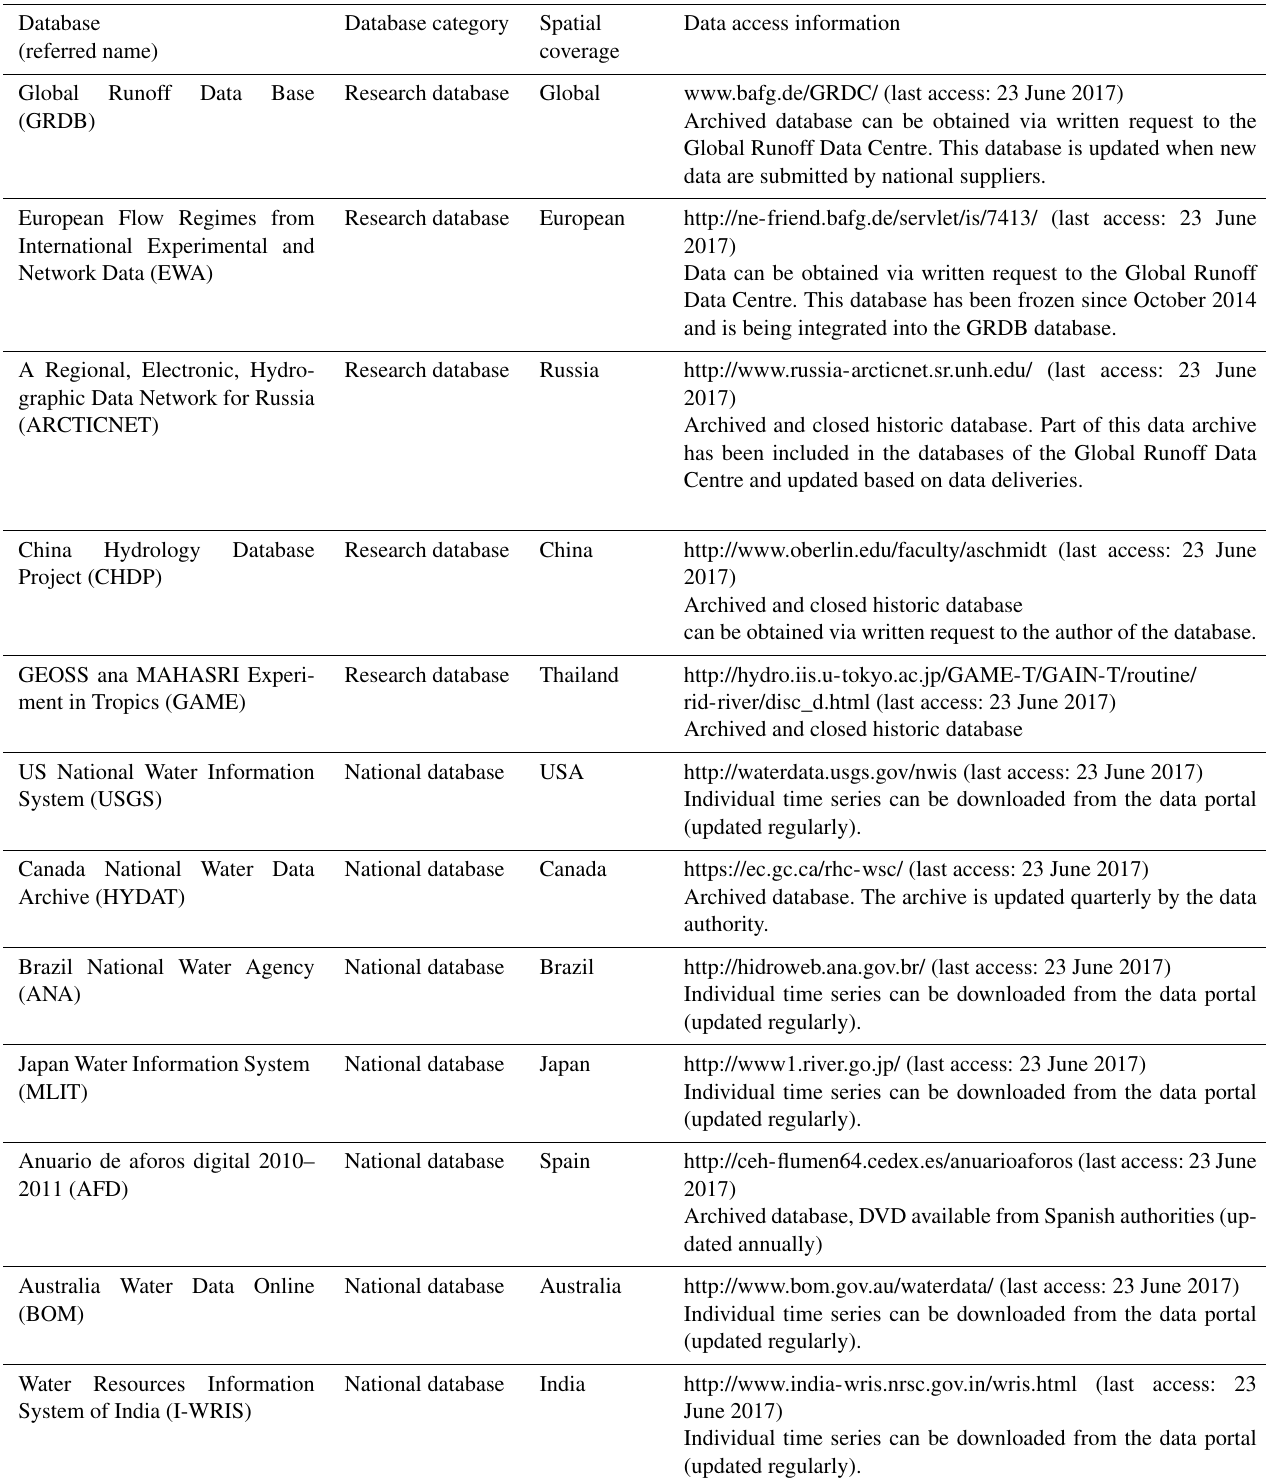
Table 1. Basic information of daily streamflow databases included in the GSIM